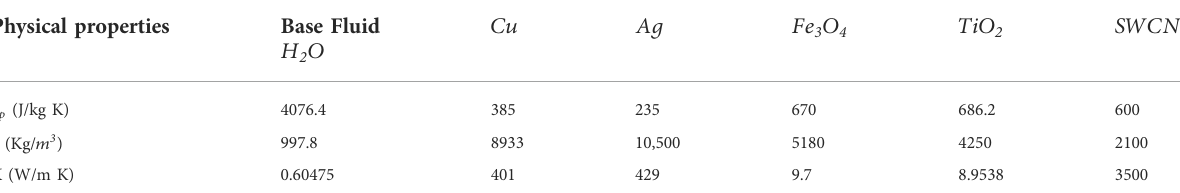
TABLE 1 Thermophysical properties of different NPs and the base fl uid.